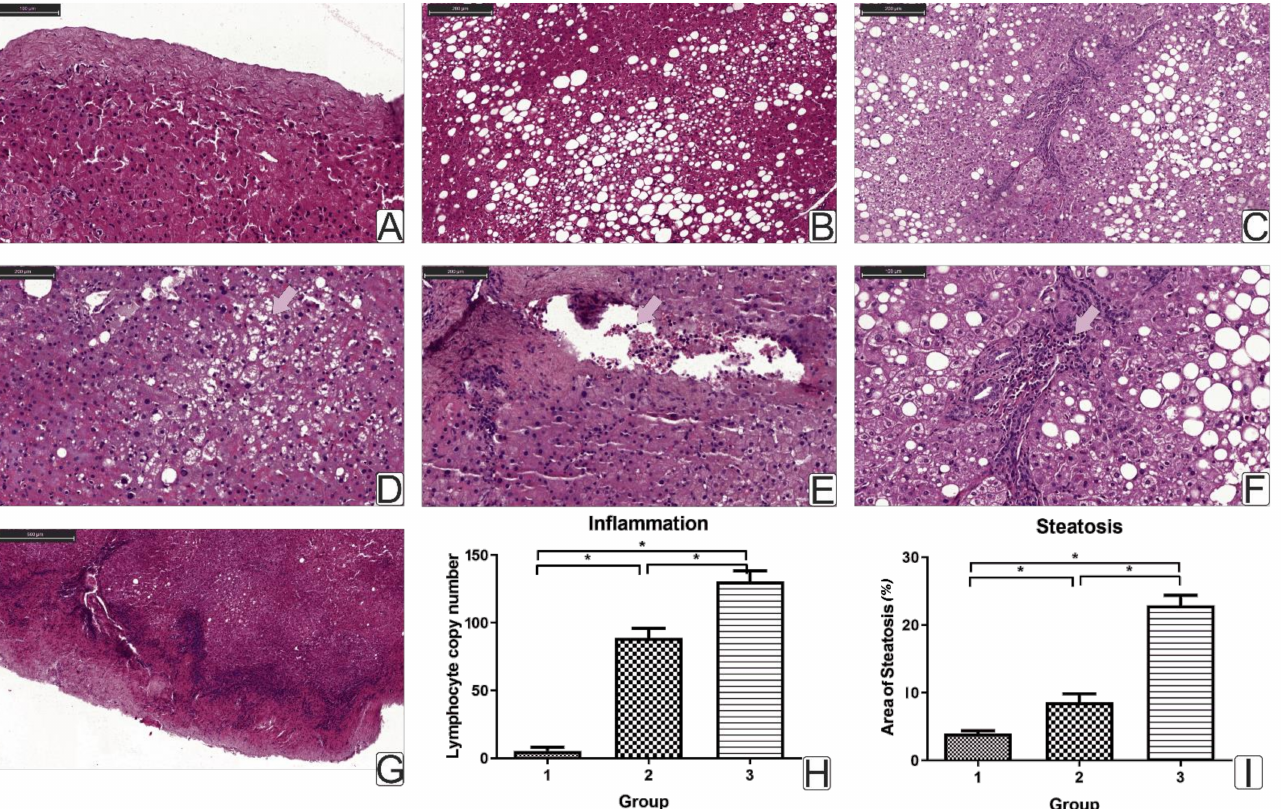
Figure 4. Histological study of liver biopsies. ( A ) Liver capsule of a healthy donor; ( B ) small, medium, and large droplet steatosis. Magnification 20 × ; ( C ) lymphocytic infiltration in the portal tract, which further spreads into the tissue to the foci of steatosis. Intracellular cholestasis and signs of dystrophy and karyolysis. In the foci of steatosis, there are large, medium, and small droplet inclusions. Magnification 10 × ; ( D ) intracellular cholestasis. Magnification 20 × ; ( E ) lymphocytic infiltration in the portal tracts. Magnification 20 × ; ( F ) lymphocytic infiltration in the portal tract, which further spreads into the tissue to the foci of steatosis. Intracellular cholestasis and signs of dystrophy and karyolysis. In the foci of steatosis, there are large, medium, and small droplet inclusions. Magnification 20 × ; ( G ) liver capsule with inflammation; ( H ) the number of lymphocytes in liver biopsies. 1—control group, 2—obesity group without T2DM, 3—obesity group with T2DM; ( I ) comparison of the area of fat inclusions of steatosis. 1—control group, 2—obesity group without T2DM, 3—obesity group with T2DM. The significance was determined using the Mann–Whitney criterion for two independent samples (* p < 0.05). In the obesity group without T2DM, small-, medium- and large-droplet steatosis